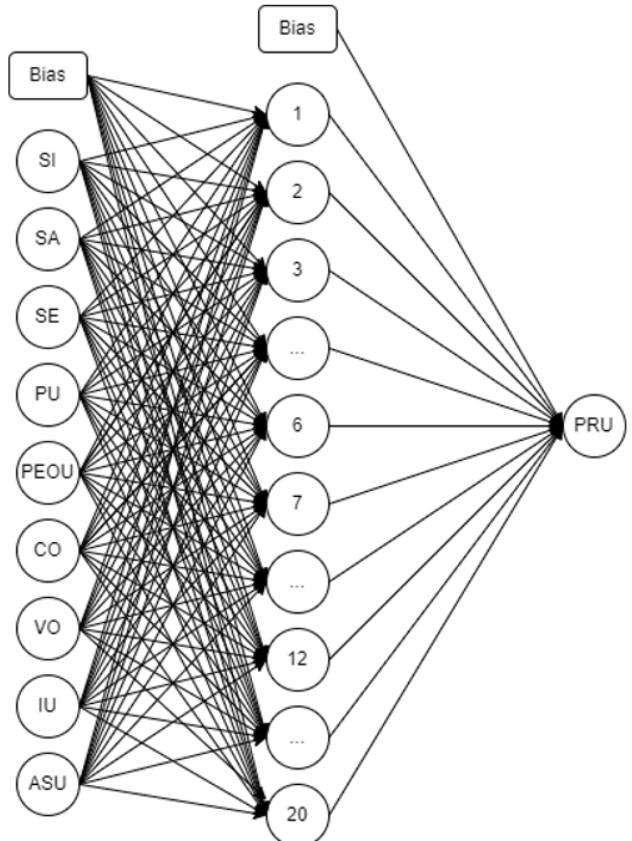
Figure 5. Artificial neural network model.